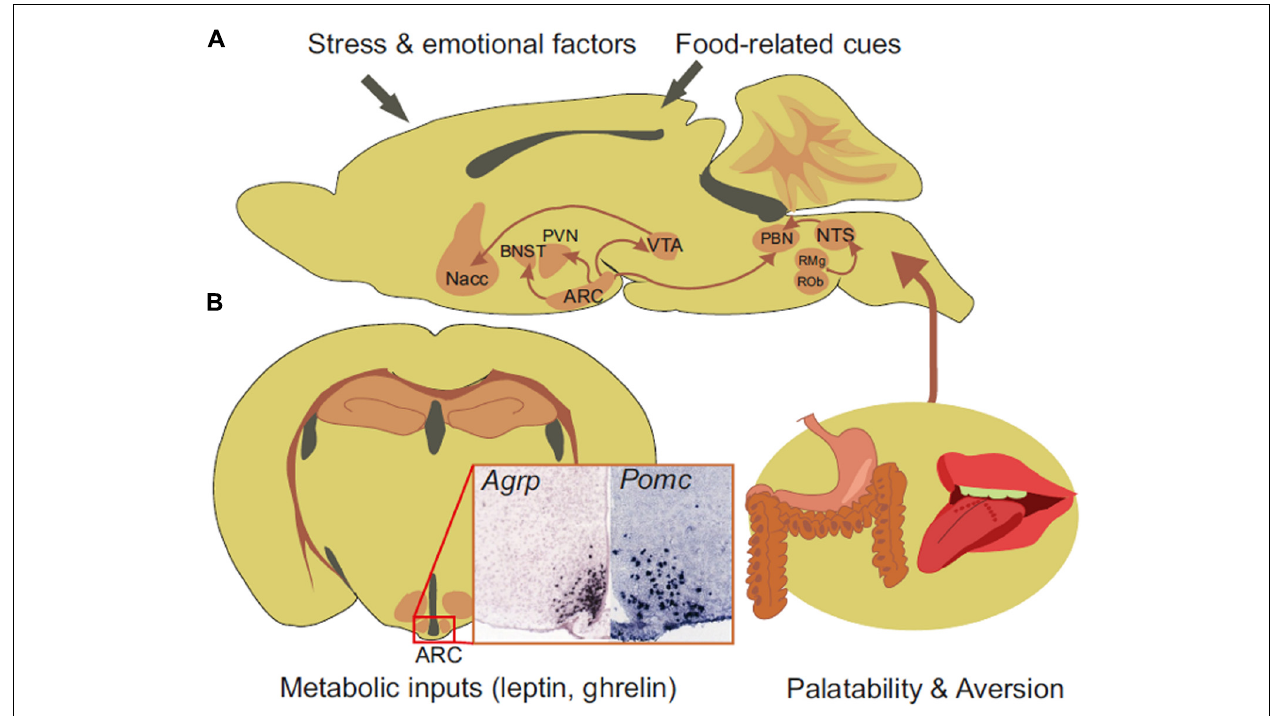
input from the raphe obscurus (ROb) and the raphe magnus (RMg) and exerts an anorectic action through the glutamatergic excitation of the PBN. AgRP neurons integrate metabolic input of hunger and have direct connections to brain regions processing reward and motivation together with food-related cues such as palatability and aversive aspect. In situ hybridization picture were downloaded from the Allen Mouse Brain Atlas [http://mouse.brain-map.org/Seattle (WA): Allen Institute for Brain Science (Lein etal., 2007). ©